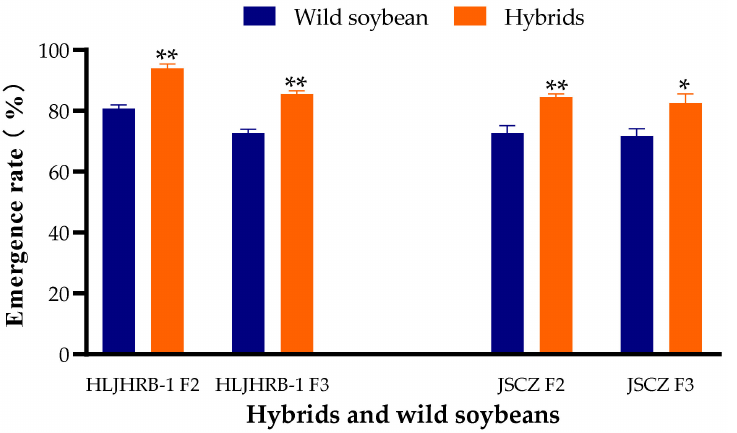
Figure 1. Emergence rate of F2, F3 hybrids and their wild soybeans. Note: * and ** indicate significant difference ( p < 0.05) and extremely significant difference ( p < 0.01) between hybrids and their wild